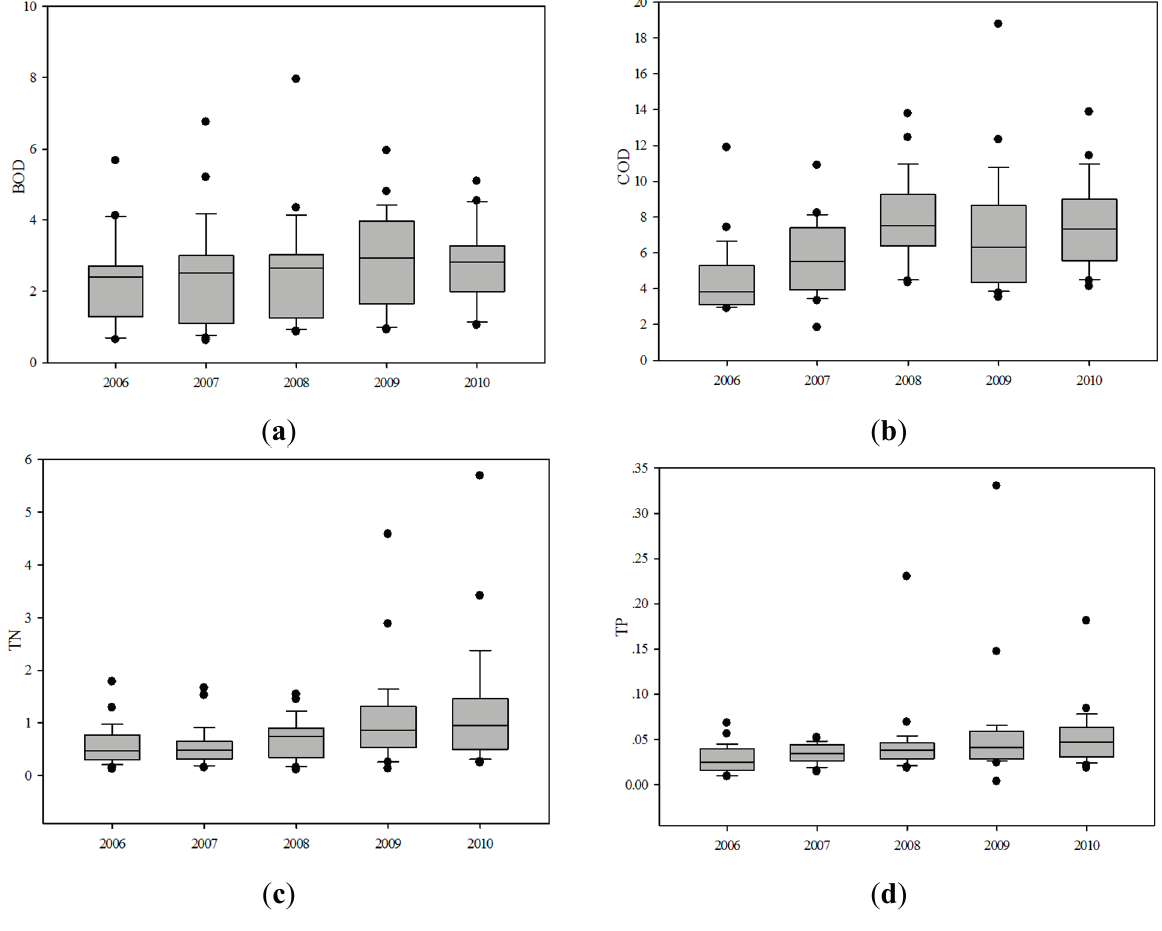
Figure 3. Temporal variations of ( a ) BOD; ( b ) COD; ( c ) TN and ( d ) TP in the study reservoirs from 2006 to 2010 (units: